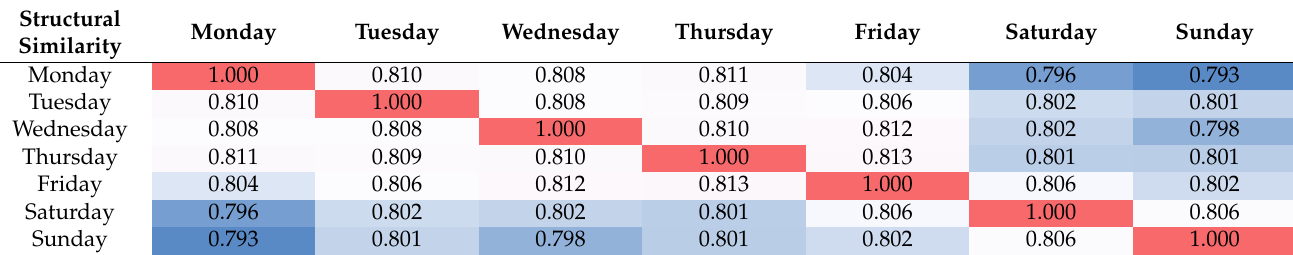
Table 4. Flow similarity of the OD matrixes in Shenzhen.